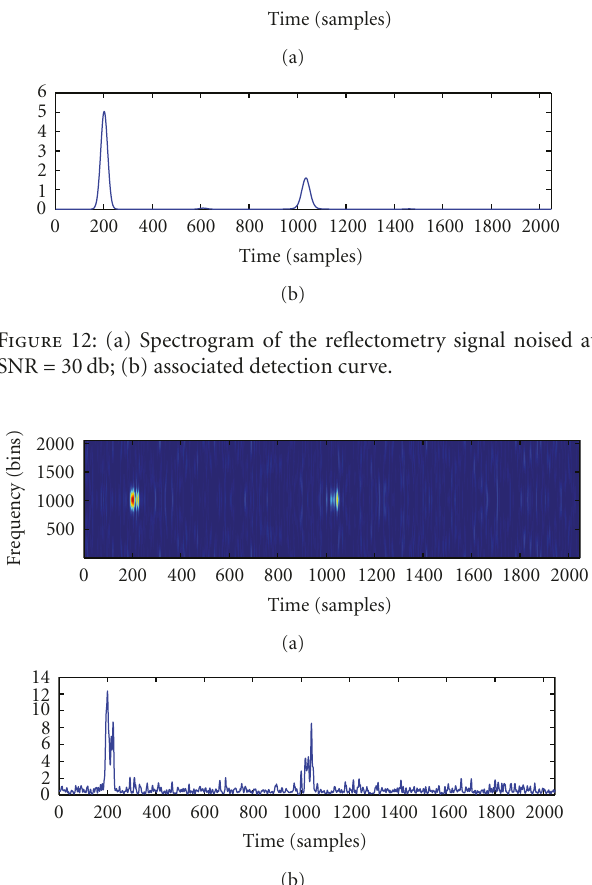
Figure 13: (a) Spectrogram of the reflectometry signal noised at SNR = − 8db; (b) associated detection curve.